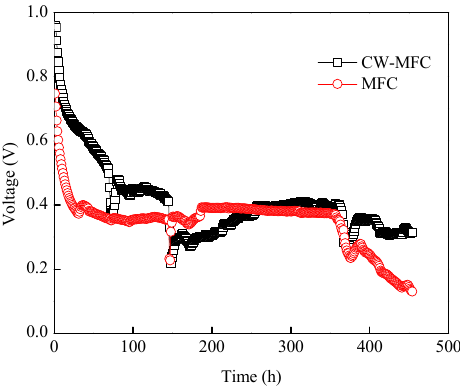
Figure 6. Voltage variation after new modified cathodes were placed in reactors. Triple sampling was operated during the period of 200–350 h.